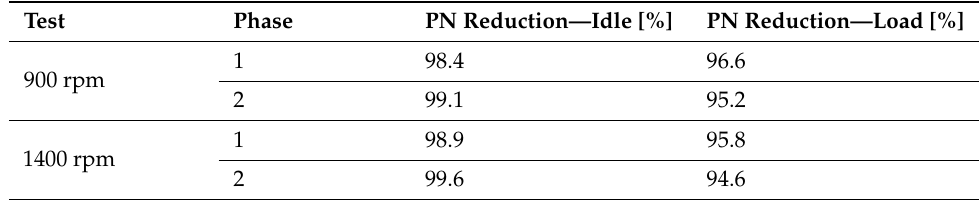
Table 11. The CPF mean PN reductions for both phases of each test